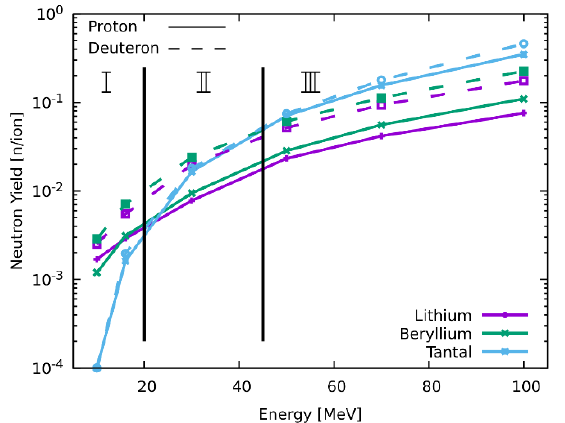
Figure 5: Neutron yield for Li, Be, and Ta as a function of the primary ion energy. The energy can be seperated into three regions, I, II, and III showing a different behaviour for the neutron yield.